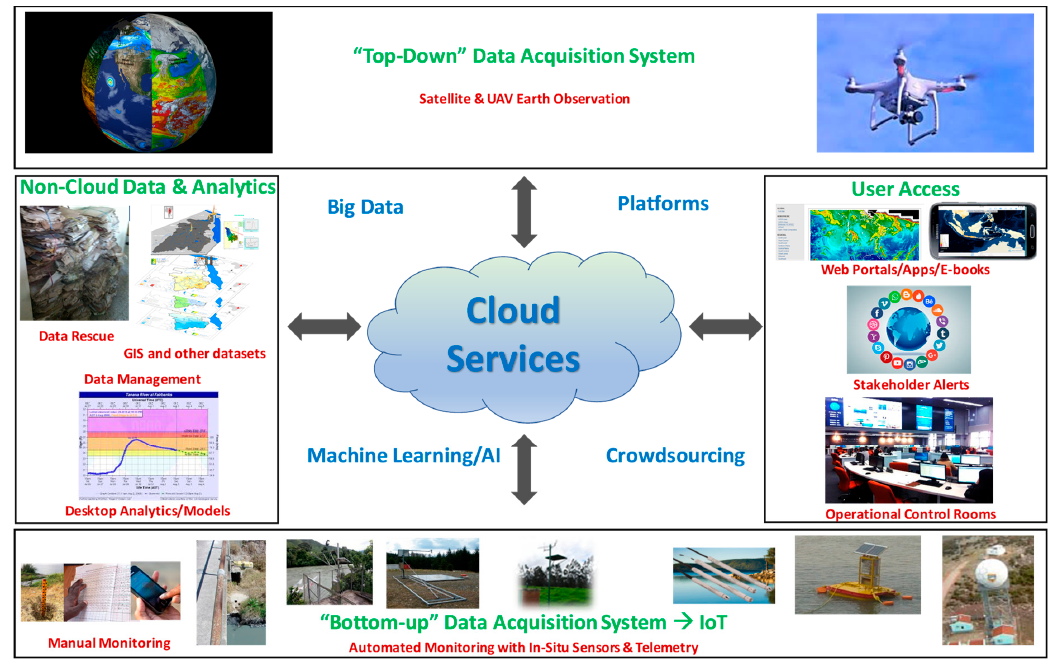
Figure 4. Modernizing the data value chain (Data Information Knowledge Decision Support).